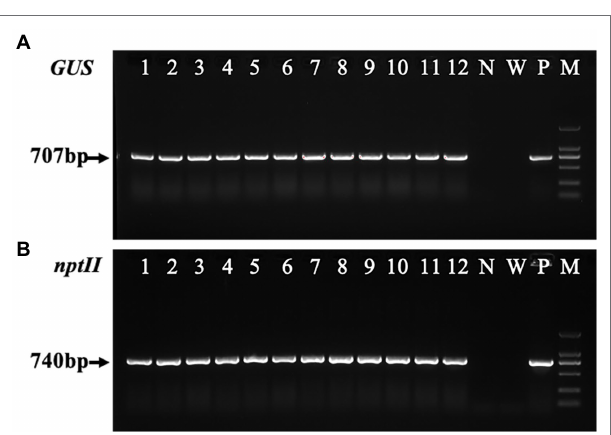
FIGURE 7 | Polymerase chain reaction (PCR) analysis of the transgenic calli and transgenic plants. (A) The PCR analysis of the ß -glucuronidase ( GUS ) gene (707 bp) isolated from transgenic calli and the leaves of the transgenic lines and non-transformed plants of the Liriodendron hybrid. (B) PCR amplification of the NPT-II gene (740 bp) from the transgenic and non- transgenic lines. Lines 1–3 are transgenic calli, and lines 4–12 are transgenic plants. N, negative control (non-transgenic sample). W, water. P, positive control (plasmid). M, DL2000